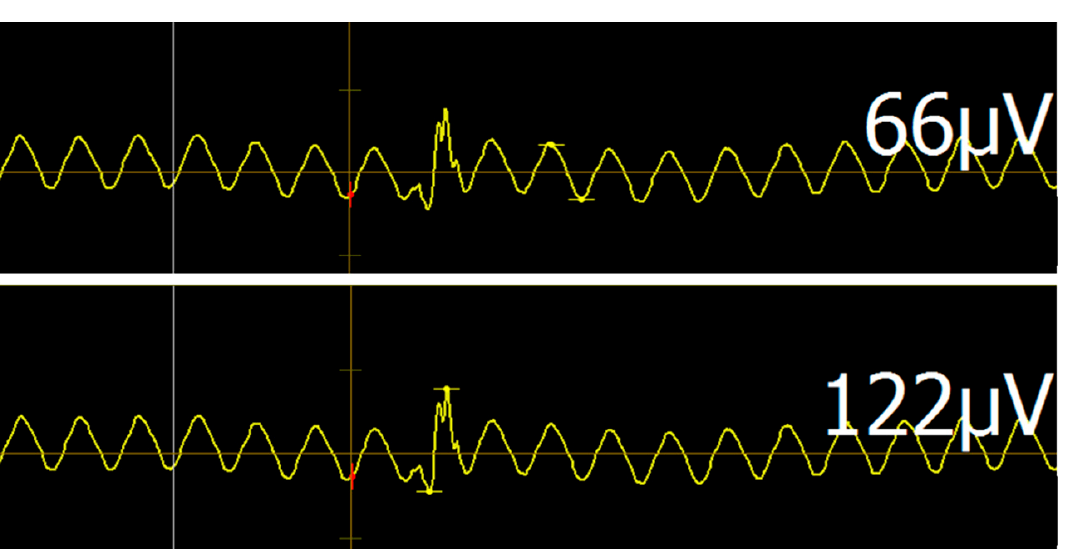
Figure 5. Motor evoked potential (MEP) disrupts 60 Hz noise. This figure shows regular 60 Hz noise disrupted by MEP occurrence. Measurements on the right correspond to amplitude between yellow measurement bars. One heuristic for detecting valid MEPs amongst regular noise is to subtract the noise amplitude from the potential MEP. If the amplitude is still >50 µV, the MEP may be considered valid (pictured). Additionally, placement of multiple stimuli at a given location can aid when MEPs are questionable. Note the two individual peaks within the MEP formed by the underlying noise reaching its minimum.